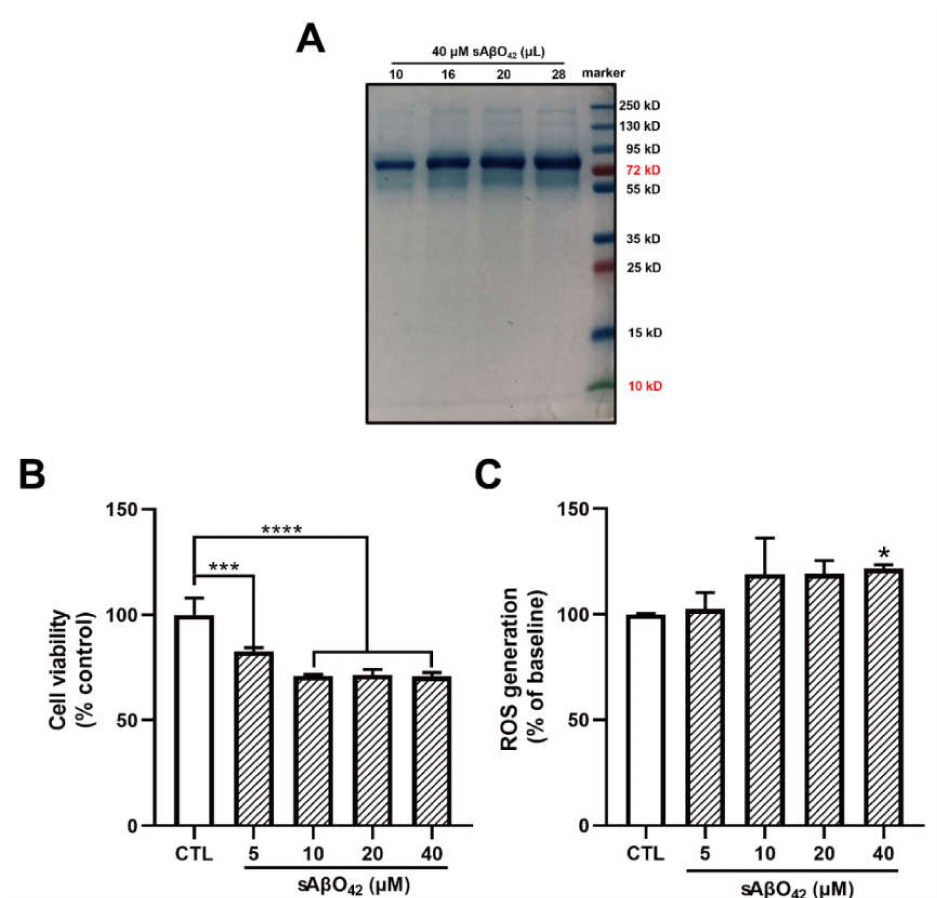
Figure 1. Murine soluble amyloid beta 42 oligomer (sA β O42) exerted negligible and disruptive effects on the barrier function of a bEnd.3 monolayer up to 40 µ M. ( A ) Identification for the sizes of the prepared A β 42 peptides using SDS-PAGE electrophoresis with Coomassie brilliant blue staining. ( B ) The cell viability and ( C ) the relative levels of reactive oxygen species (ROS) in bEnd.3 cells treated with sA β O42 (1–40 µ M) for 24 h. Data are shown as means ± SD of at least three independent experiments and were analyzed by one-way ANOVA followed by a post hoc Dunnett’s test. * p ≤ 0.1, *** p ≤ 0.001, **** p ≤ 0.0001 vs. control